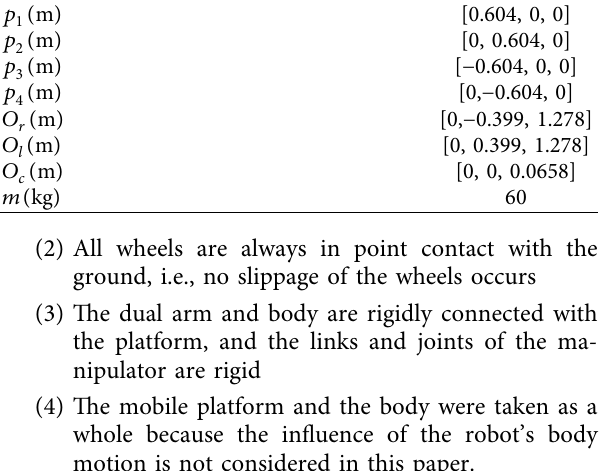
Table 1: Related parameters of the robot system. Parameters